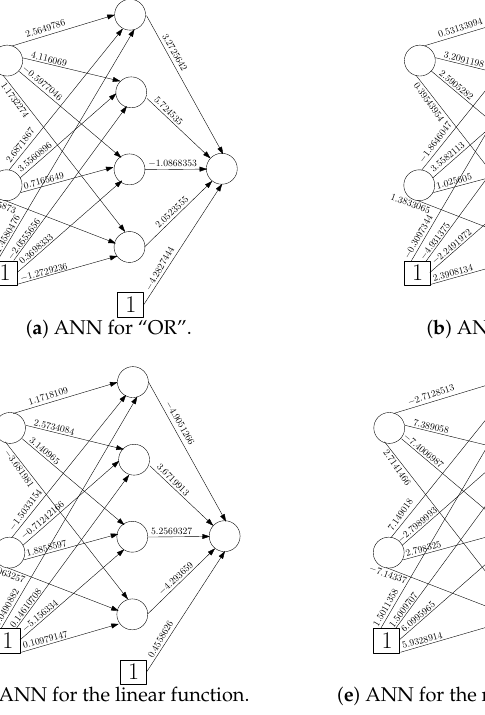
Figure 5. The trained ANNs for different data